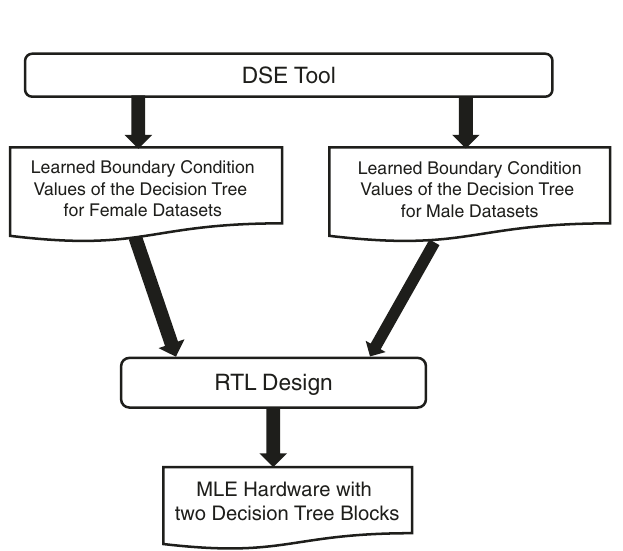
Fig.7|MLEhardwaregeneration fl ow. ThestagesforcreatingMLEhardwarefrom the design space exploration (DSE) tool are shown.